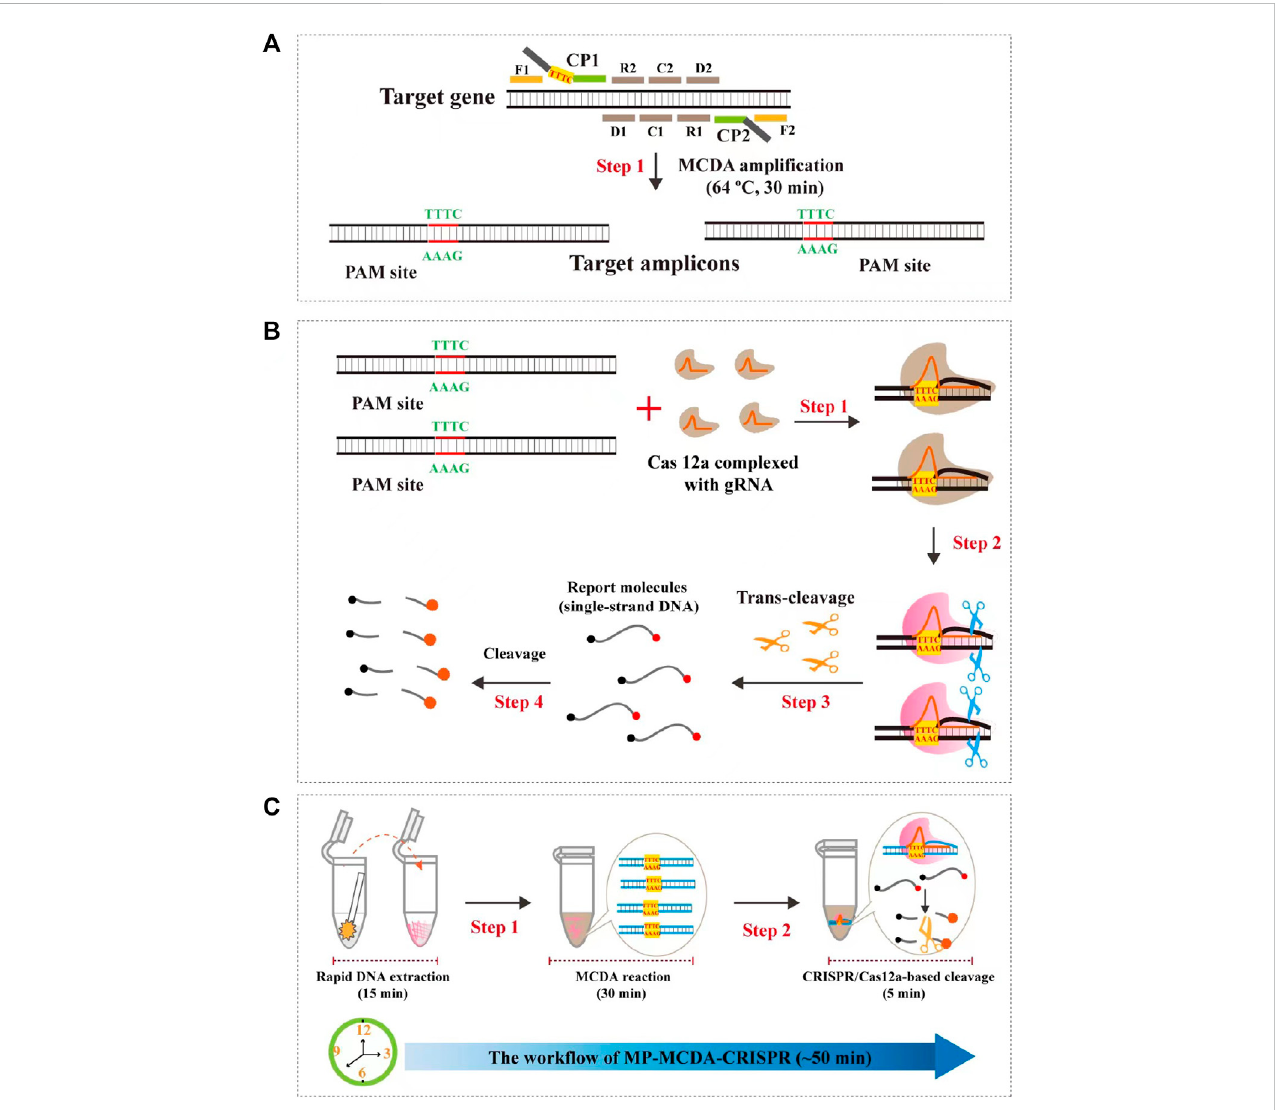
Schematic illustration of the principle of the MP-MCDA-CRISPR assay. (A) Schematic illustration of the principle of MCDA with the modi fi ed primer. The primer CP1 was modi fi ed with a PAM site (TTTC) at the linker region. After ampli fi cation, a CRISPR-Cas12a recognition site was constructed in the target amplicons. (B) Schematic illustration of the CRISPR-Cas12a detection system. Upon recognition of the target DNA, the CRISPR-Cas12a-gRNA complex cleaves the single stranded DNA reporter molecule and responds with release of fl uorescence signal. (C) Overview of the MP-MCDA-CRISPR work fl ow. MP-MCDA-CRISPR assay employs three closely linked steps: DNA extraction (step 1), MCDA pre-ampli fi cation (step 2), CRISPR-Cas12a cleavage and data report (step 3). The whole process could be completed in 50